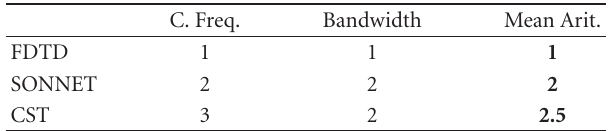
Table 3: Score of the